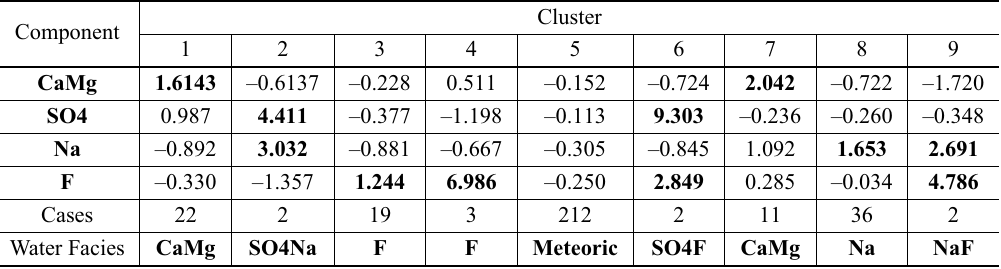
Components final cluster centers and clusters name